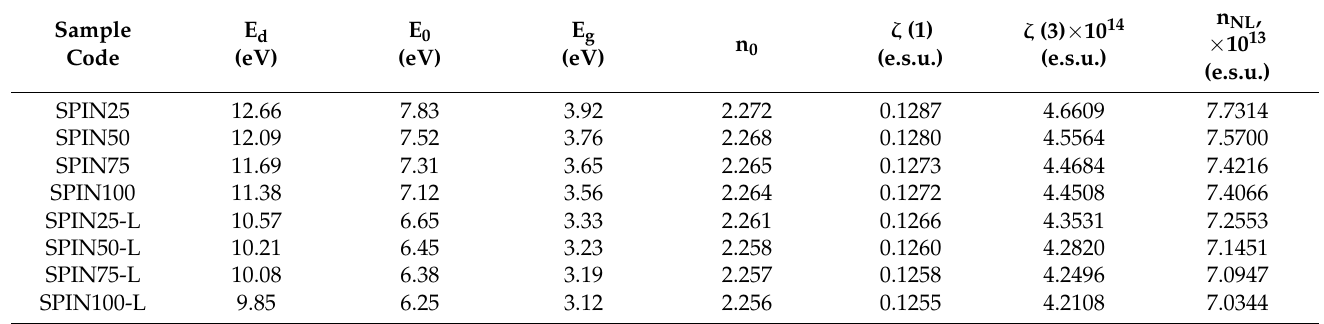
Table 4. Light dispersion parameters for the PI-based supramolecular